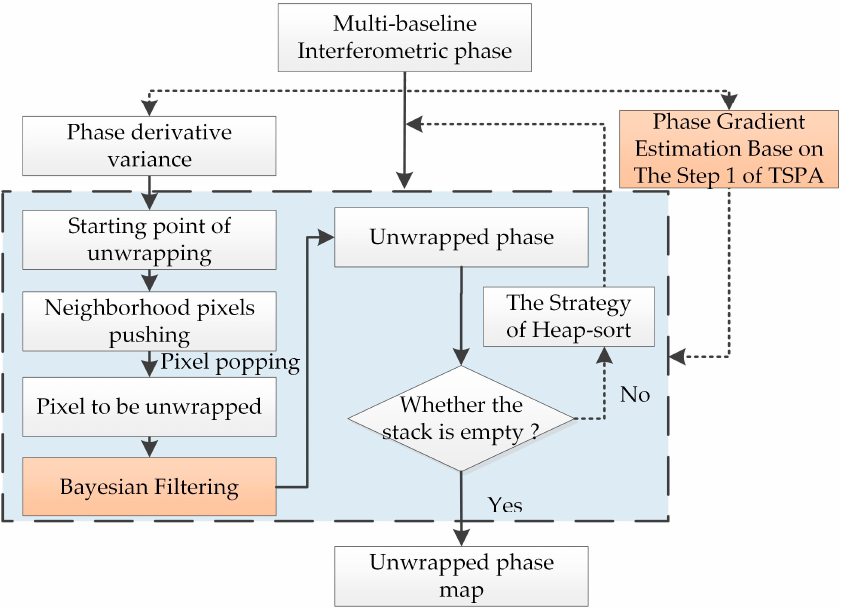
Figure 2. Schematic representation of two-stage programming approach (TSPA)-based Bayesian filtering multi-baseline phase unwrapping (MBPU) method framework.